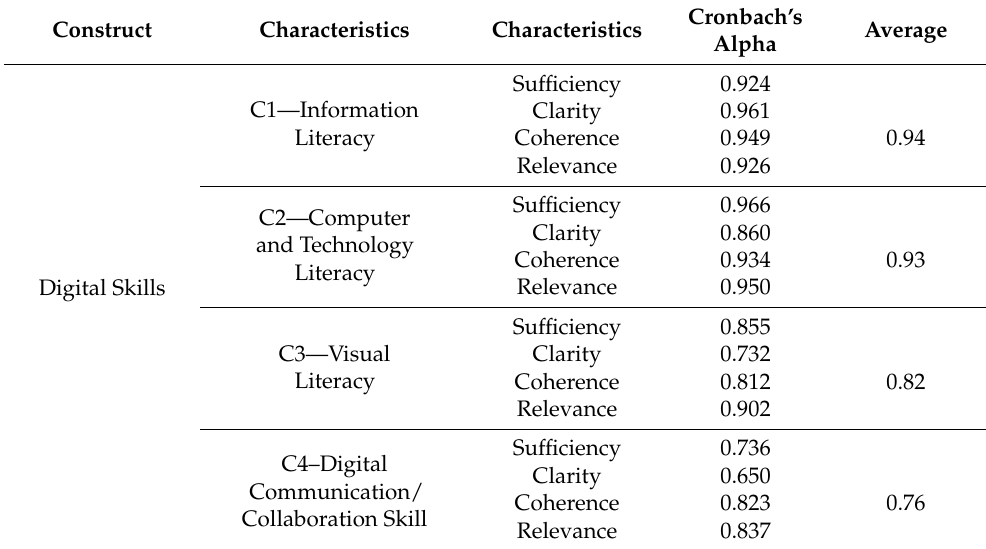
Table 5. Cronbach’s Alpha values for each of the components and characteristics of digital